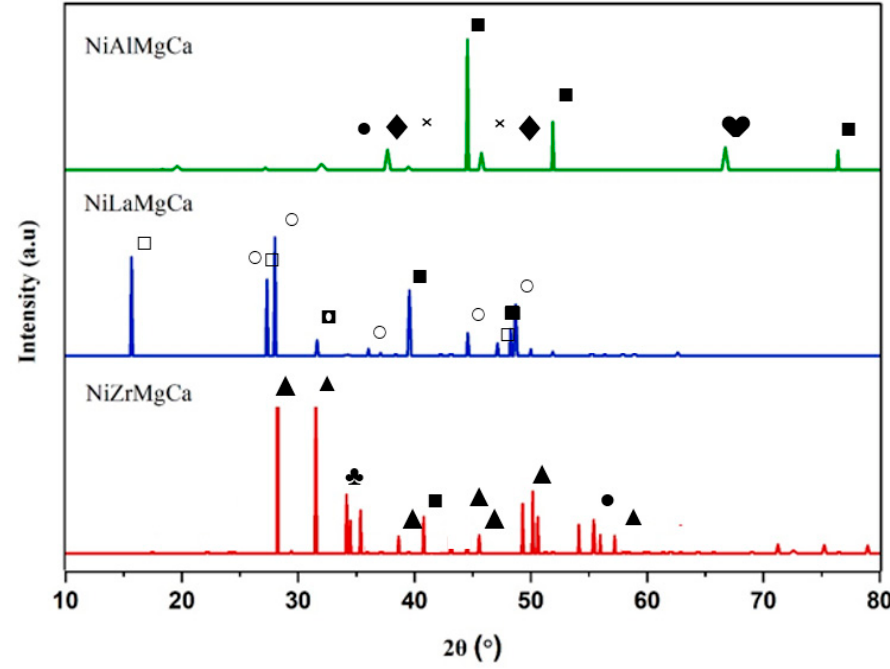
Figure 3. Crystalline phase of XRD profile reduced catalyst; Ni ( ■ ); MgO ( ● ); CaO ( ♥ ); Ca (OH) 2 ( ♣ ); Al 2 O 3 ( ▲ ); NiAl 2 O 4 (×); La 2 O 3 ( ○); La (OH) 3 (□); NiLa 2 O 4 (◘); ZrO 2 (▲) .